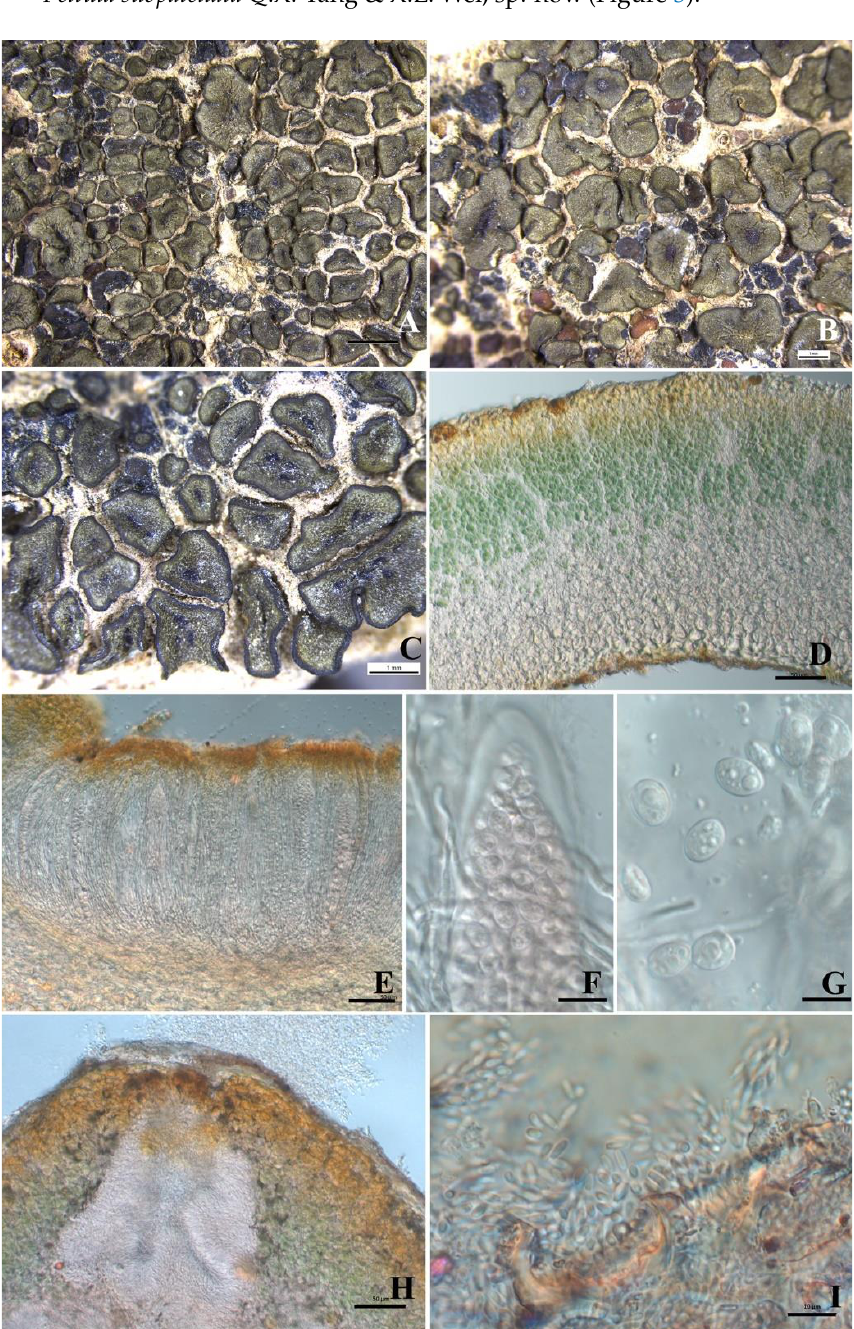
Figure 3. The thallus habit and the anatomic structure of Peltula subpatellata (holotype). ( A – C ) Squamulose thallus and immersed apothecia. ( D ) Thallus section. ( E ) Section of apothecium. ( F ) Biunicate ascus with a lacerate outer-wall-like gelatinous sheath. ( G ) Elliptical ascospores with oil drop. ( H ) Pycnidia. ( I ) Conidia. Bars: ( A ) = 2 mm, ( B − C ) = 1 mm, ( D − E ) = 50 μm, ( F − G ) = 10 μm, ( H ) = 50 μm, ( I ) = 10 μm.